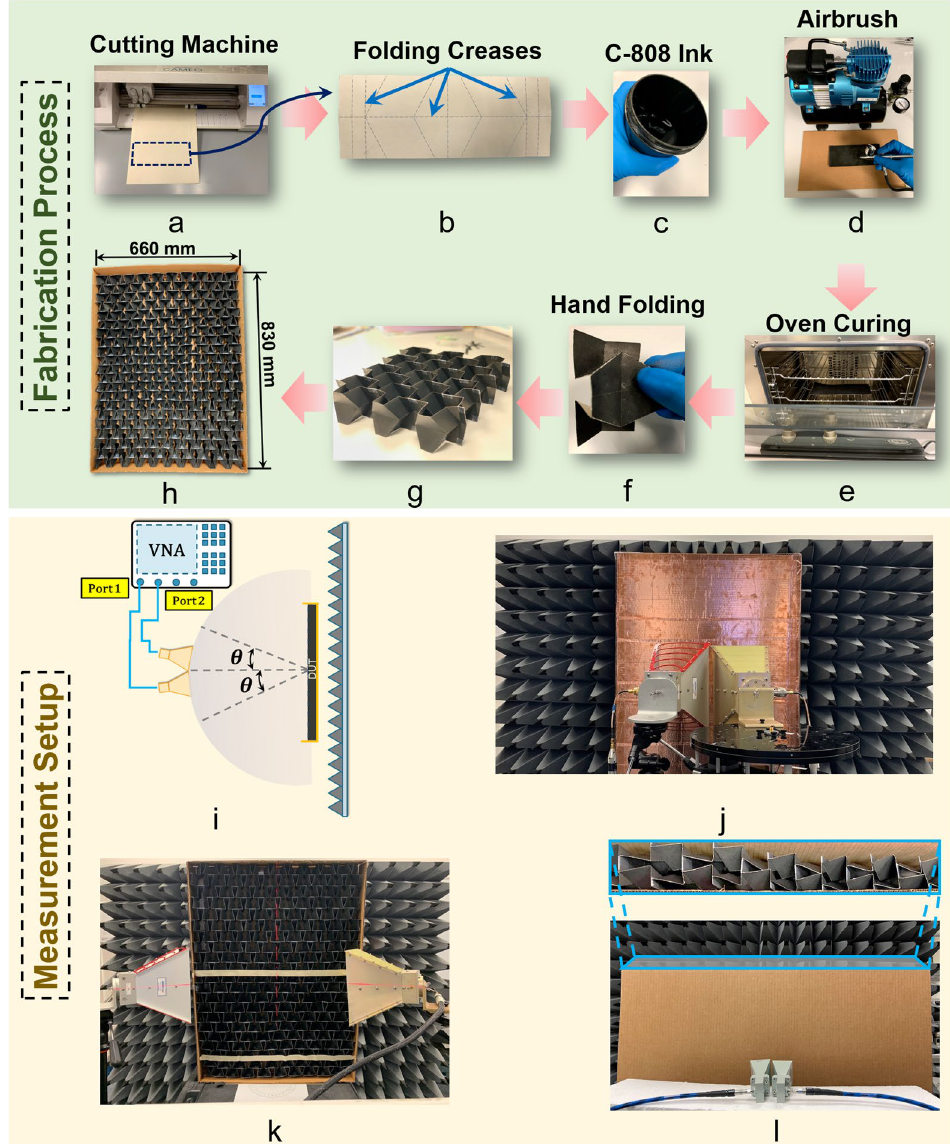
Figure 8. Fabrication process of the TMP absorber: ( a ) cardstock paper is scored using a Silhouette Cameo, ( b ) scored flat front panel, ( c ) C-808 conductive carbon ink, ( d ) spraying ink with airbrush, ( e ) curing in the oven, ( f ) folding flat panel, ( g ) several folded panels joined together, and ( h ) prototype of TMP absorber inside a box frame. Measurement setup of our proposed absorber: ( i ) Schematic of setup. ( j ) Setup used for calibration. ( k ) Setup for broadside illumination with the TE mode at an incident angle of θ illumination with the TE mode at an incident angle of θ